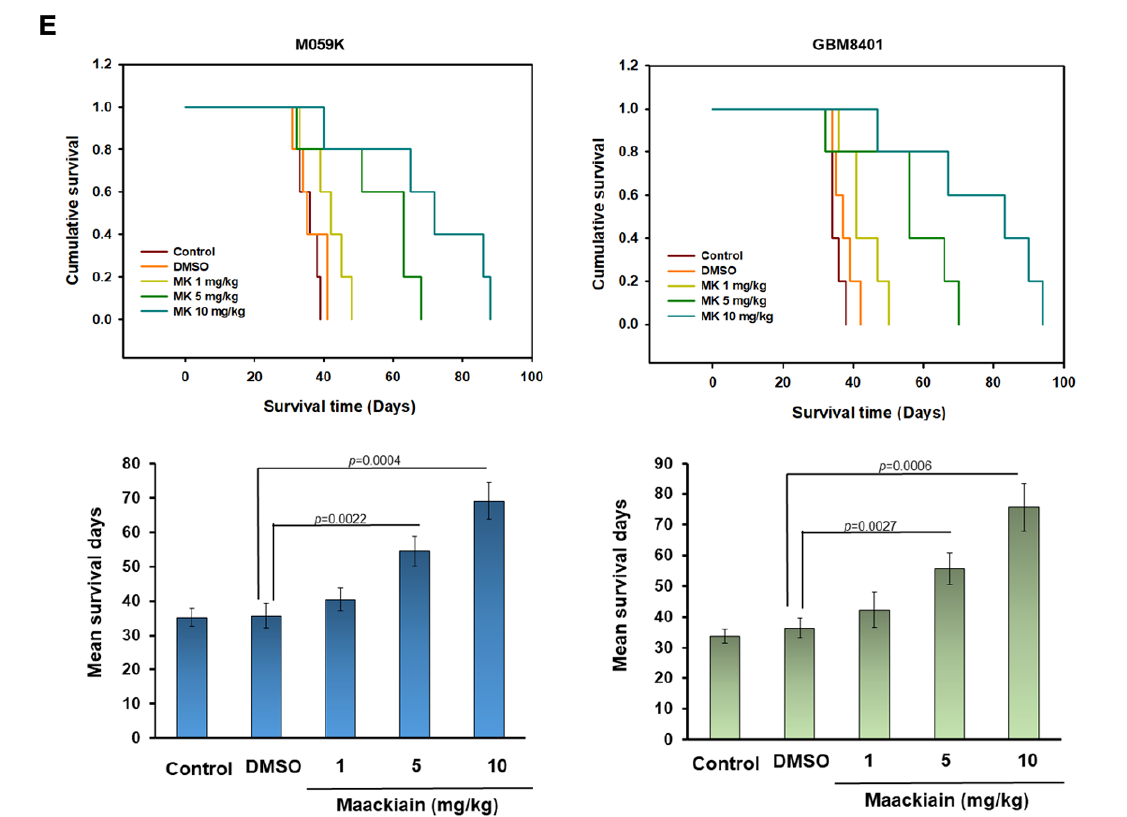
Figure 9. Maackiain (MK) has a significant antitumor effect in an immunodeficient mouse tumor model of a dorsal back subcutaneous xenograft. M059K or GBM8401 cells were inoculated subcutaneously on the dorsal back of male BALB/c nude mice for tumor growth. Mice were randomly assigned (n = 6 for each group) to receive five different regimens: normal saline, DMSO, 1 mg/kg MK, 5 mg/kg MK, and 10 mg/kg MK. Treatments were administered intraperitoneally on days 10, 13, and 16. ( A ) Mouse body weight was monitored at 2-day intervals continuously. There was no significant change in body weight overall. ( B ) Tumor volumes were measured every other day to obtain the tumor growth curves. Tumor growth was slower among MK-treated mice than in the DMSO group, particularly in the group treated with 10 mg/kg MK. ( C ) At day 30, mice were killed under anesthesia and tumors were carefully excised. Excised tumor size was smaller among MK-treated mice. ( D ) Tumor weight was remarkably reduced in the MK-treated group compared with the control (normal saline) and DMSO groups in mice injected with M059K and GBM8401 cells, respectively. ( E ) The survival median of mice was evaluated for the five treatment groups until day 94. Median survival was significantly prolonged in MK-treated tumor-bearing mice compared with controls.